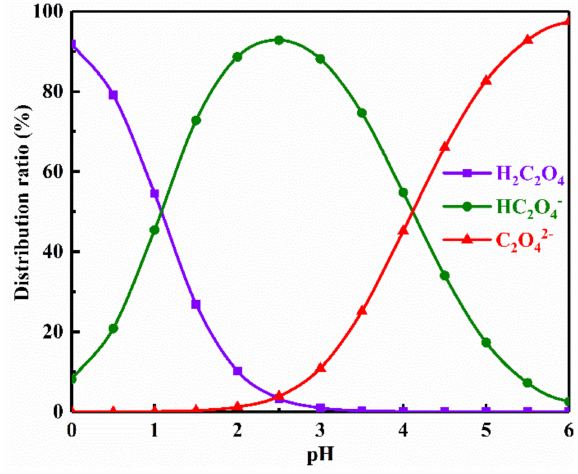
Figure 3. Effect of pH value on the distribution of various species in oxalic acid solution.